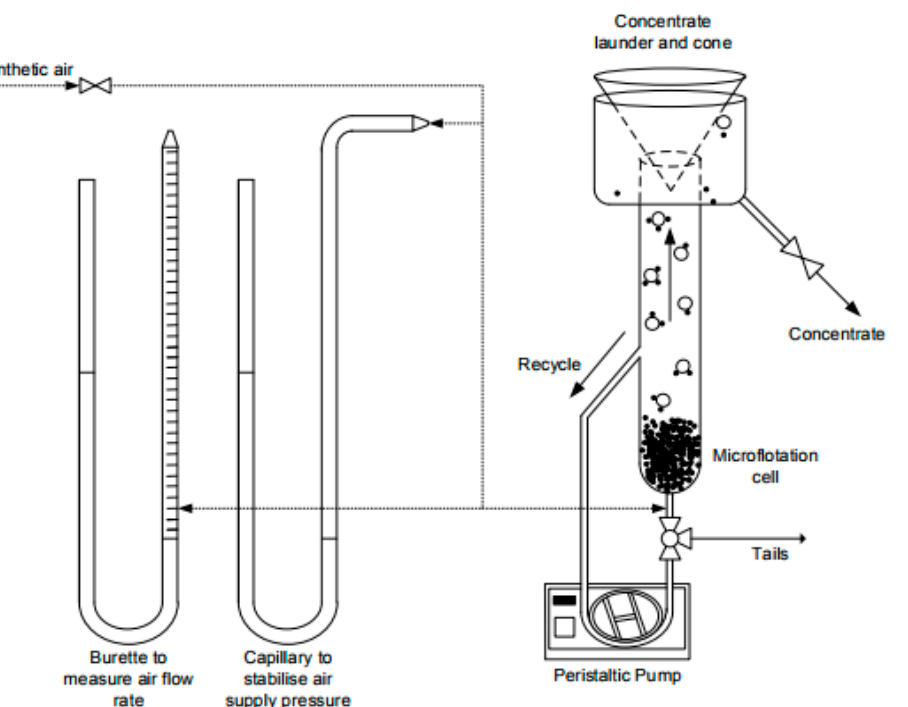
Figure 1. A schematic representation of the University of Cape Town (UCT)-Centre for Minerals Research (CMR) microflotation cell adapted from Nyabeze and McFadzean [21].